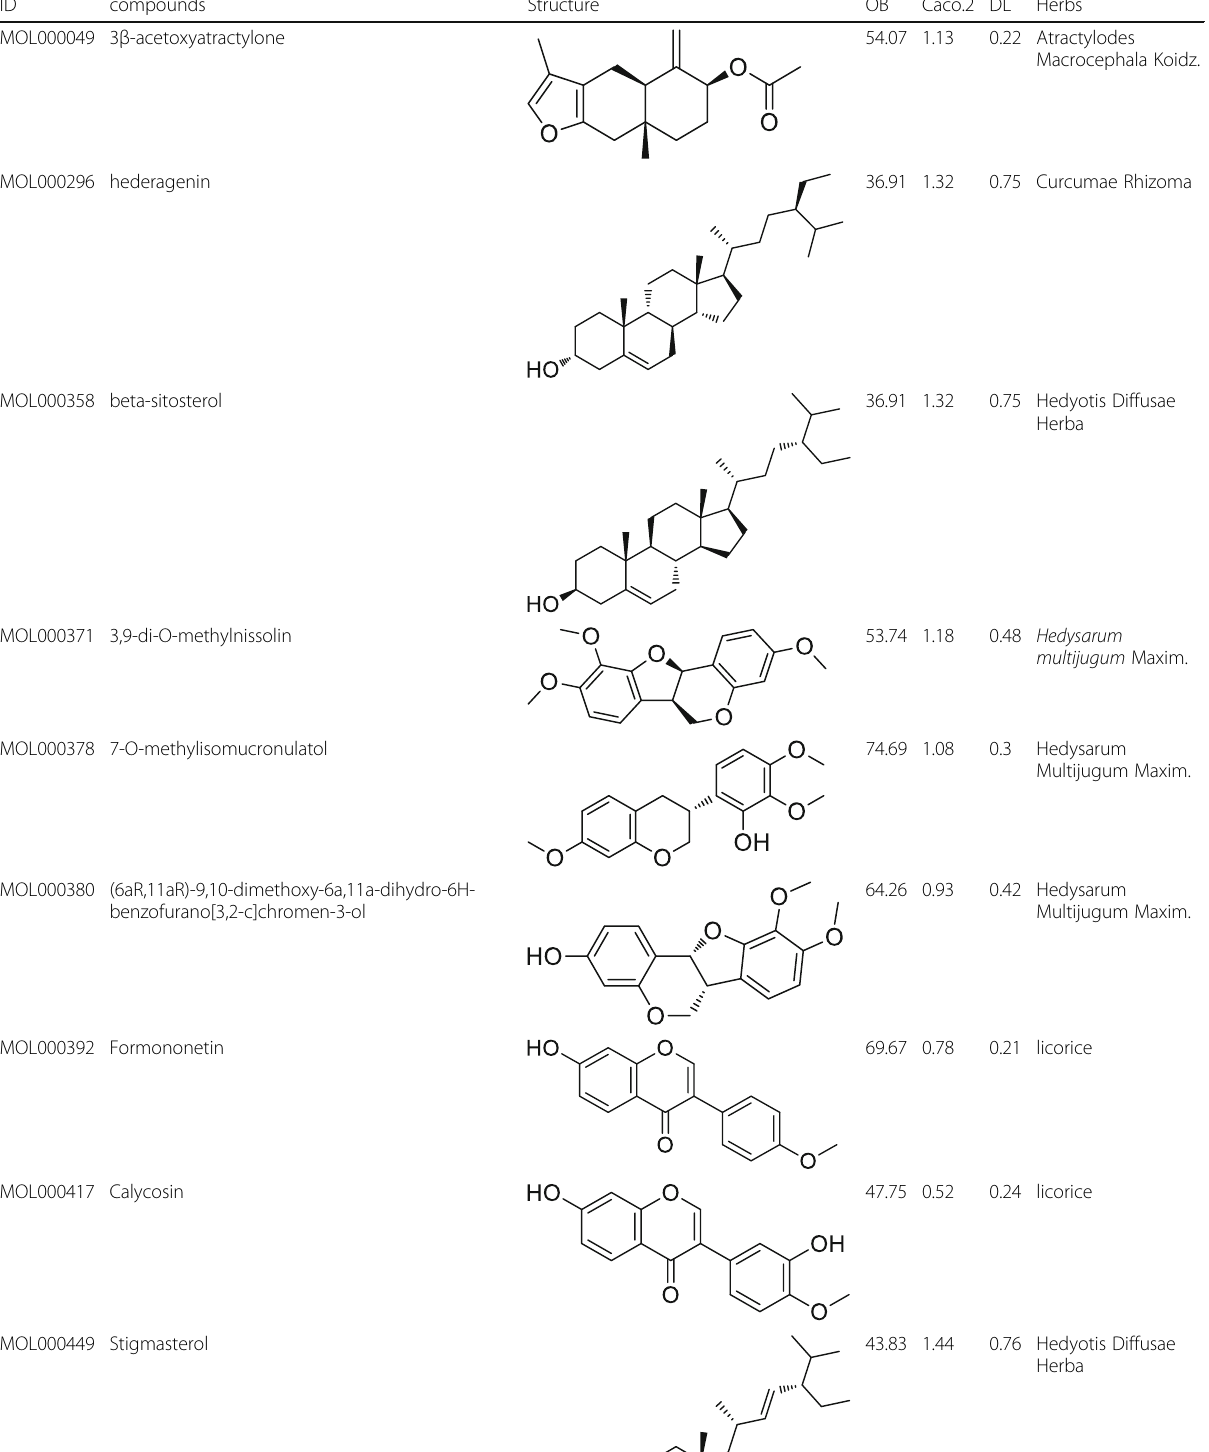
Table 1 Information of active compound by ADME